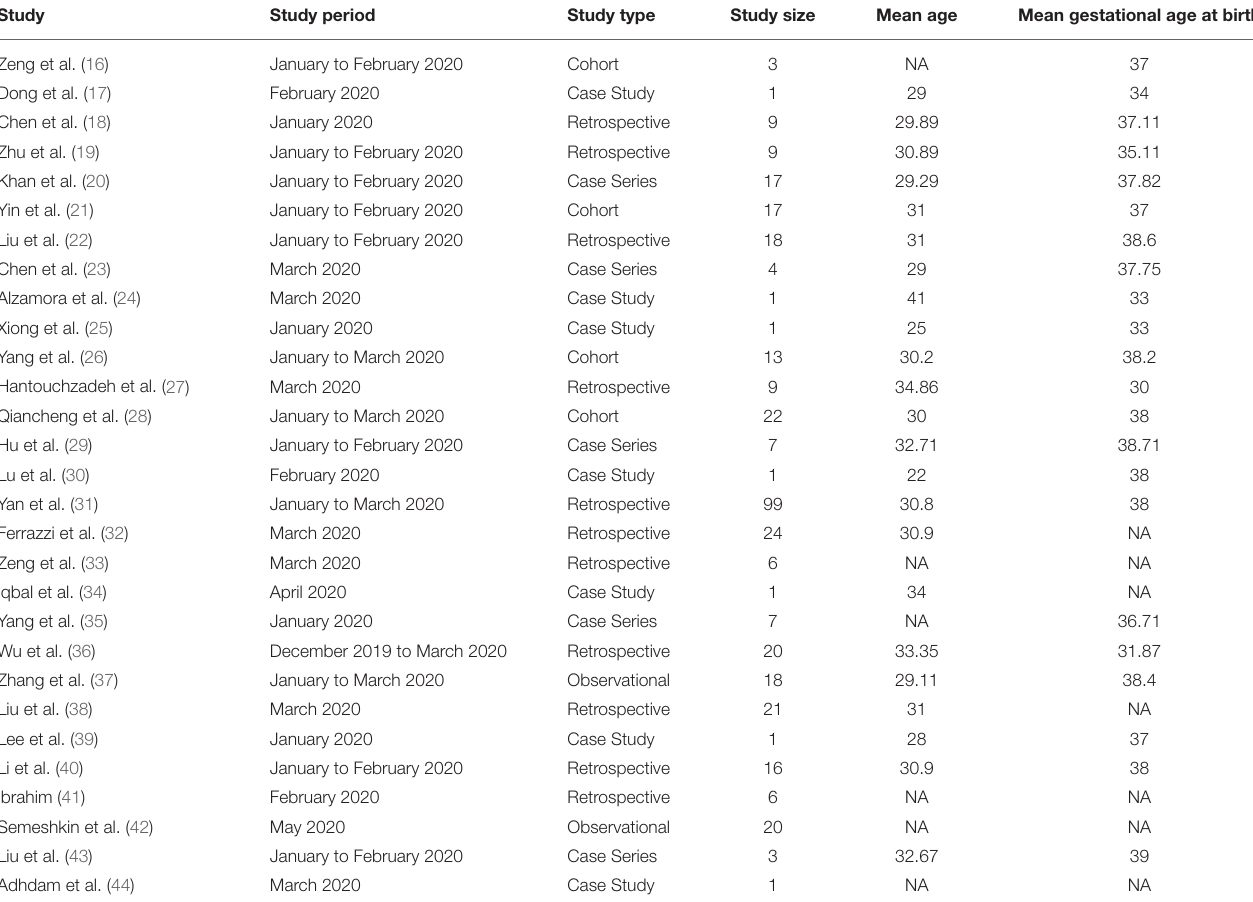
TABLE 1 | Baseline characteristics of included studies.